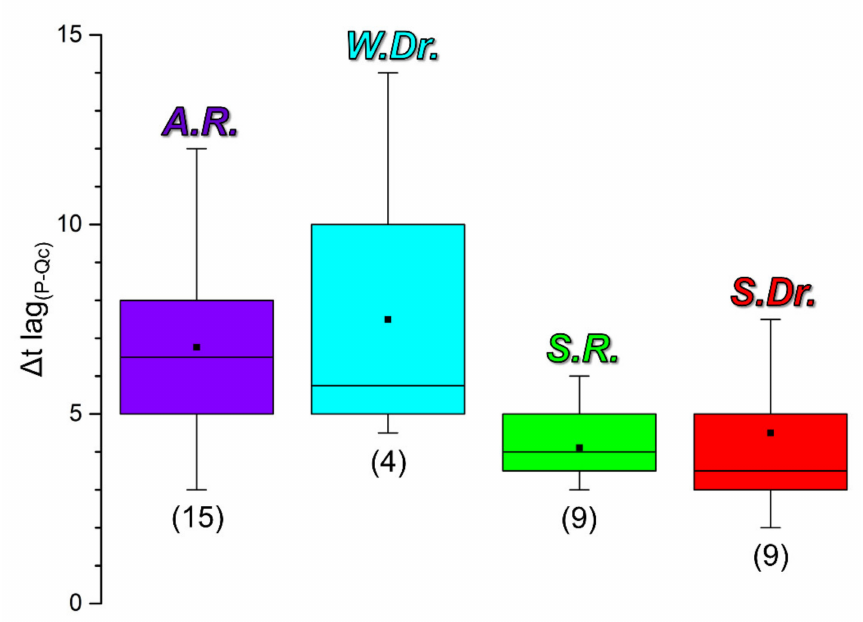
Figure 7. Boxplots of the P-Q lag times ( ∆ t lag (P − Qc) ) observed at the Pollaccia spring. Data were grouped according to the hydrological phases: autumn recharge ( A.R. ), winter drought ( W.Dr. ), spring recharge ( S.R. ), and summer drought ( S.Dr. ). The numbers in the brackets refer to the number of storm hydrographs included in each